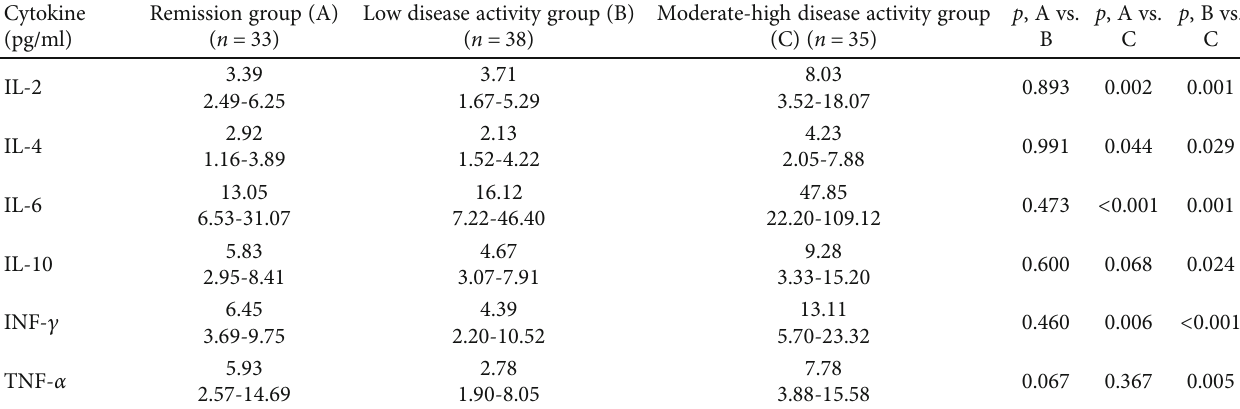
Table 2: Serum cytokine levels of RA patients in each disease activity